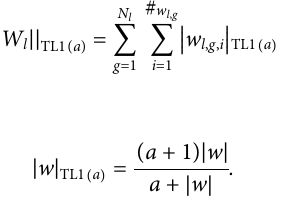
Frontiers in Applied Mathematics and Statistics |